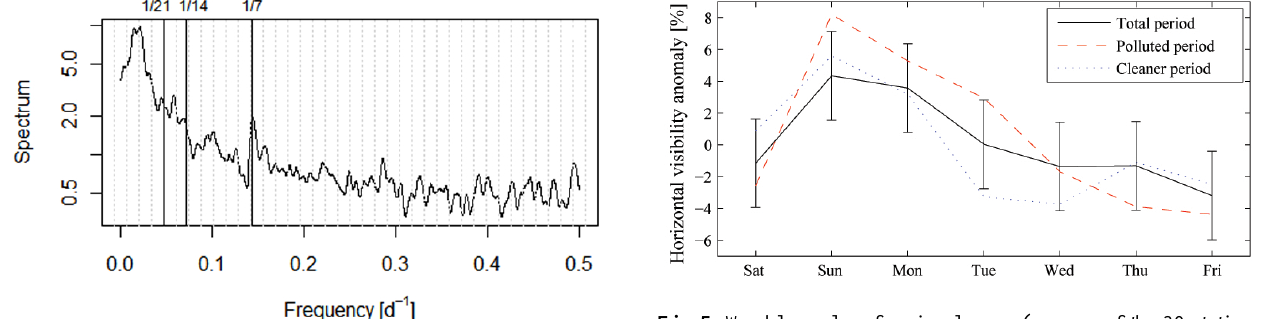
Fig. 5. Weekly cycles of regional mean (average of the 30 stations in the Black Triangle) horizontal visibility anomaly, for the entire 1983–2008 period (solid black line), the more polluted 1983–1987 period (red dashed line) and the cleaner 2004–2008 period (blue dotted line). All days with fog are removed from the data. Vertical bars show ± 1 standard